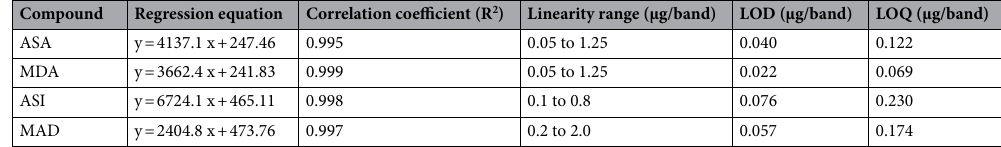
Table 2. Validation parameters of the four centellosides ASA, MDA, ASI and MAD.